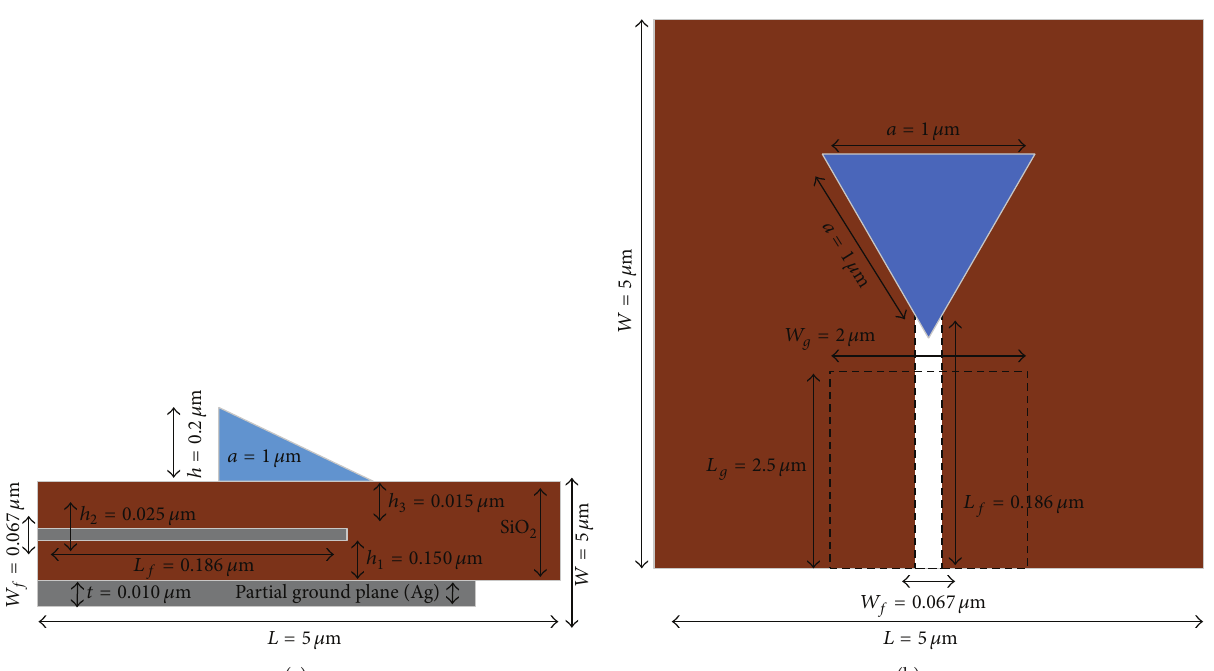
Figure 2: (a) Side view of ETDRNA. (b) Top view of ETDRNA with equal side lengths “ 𝑎 .”